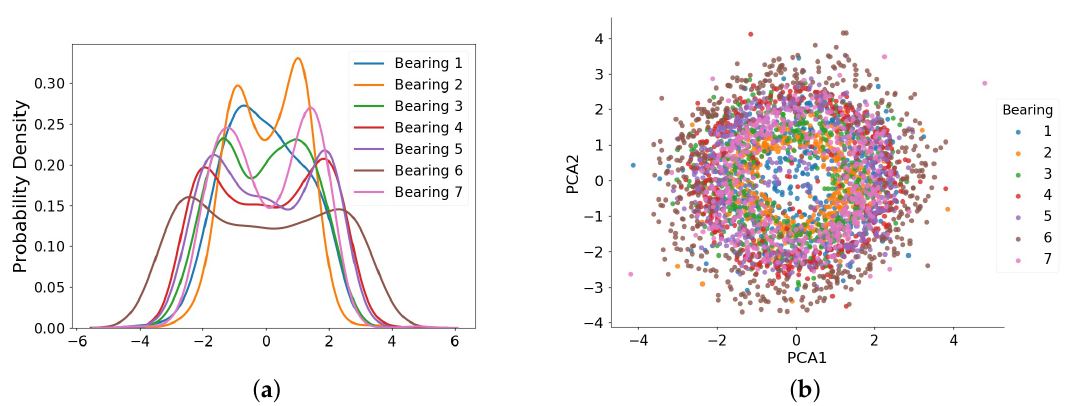
Figure 1. Distribution characteristics of normal state data of seven bearings from IEEE PHM 2012 Challenge dataset with ( a ) probabilistic density distribution and ( b ) feature